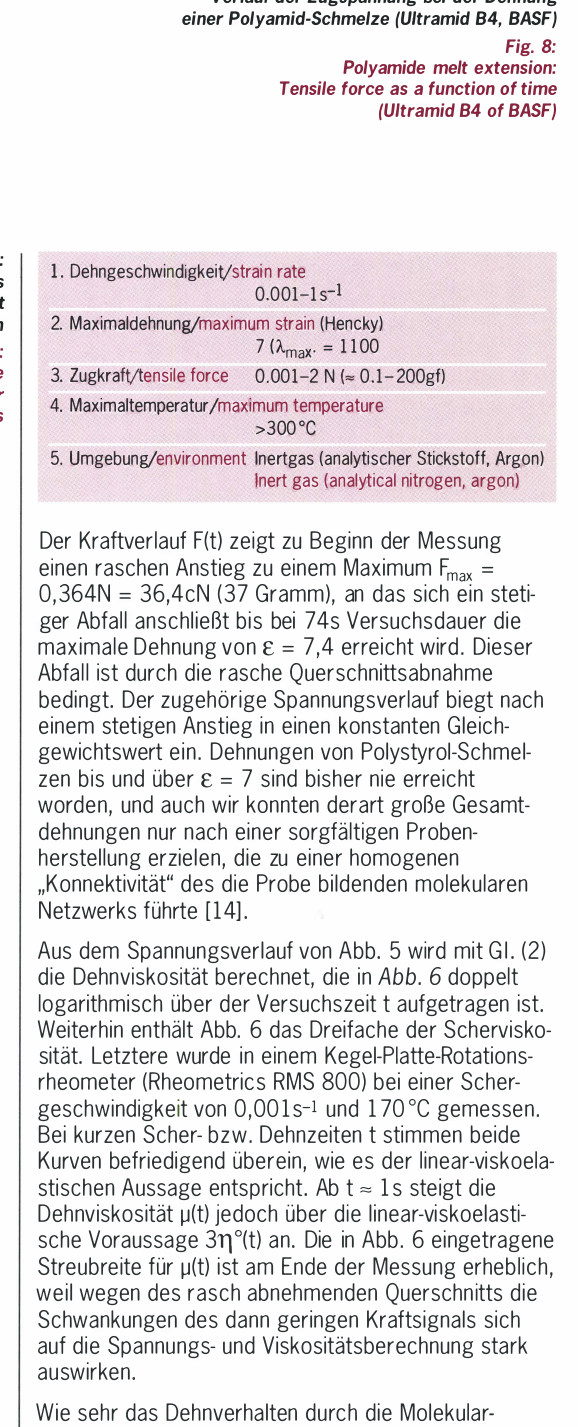
einer Polyamid-Schmelze (Uitramid 84, 8ASF) Fig. 8: Polyamide melt